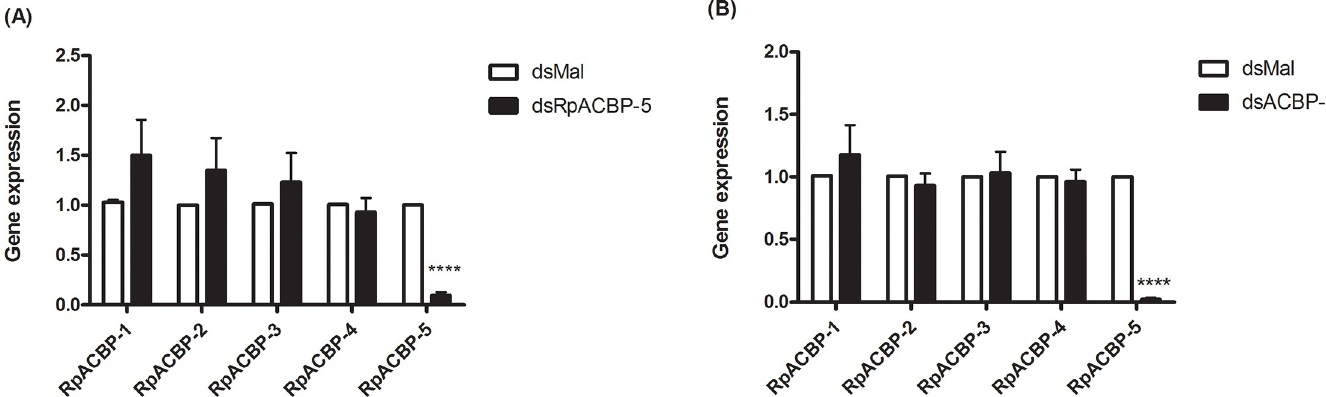
Fig 5. RpACBP-5 knockdown does not significantly affect expression of the other RpACBP genes. Fasting adult females were injected with 1 μ g of dsRpACBP-5 or dsMal, fed three days later and dissected at the fourth day after blood meal. Posterior midguts (A) and ovaries (B) were obtained and homogenized. Samples were subjected to qPCR, for determination of RpACBP-1 , RpACBP-2 , RpACBP-3 , RpACBP-4 , and RpACBP-5 mRNA levels, using Rp18S expression as reference gene. The bars are means ± SEM. ( ���� ): significantly different from dsMal by Student’s t -test with p < 0.0001; n = 8 (A) and n = 7